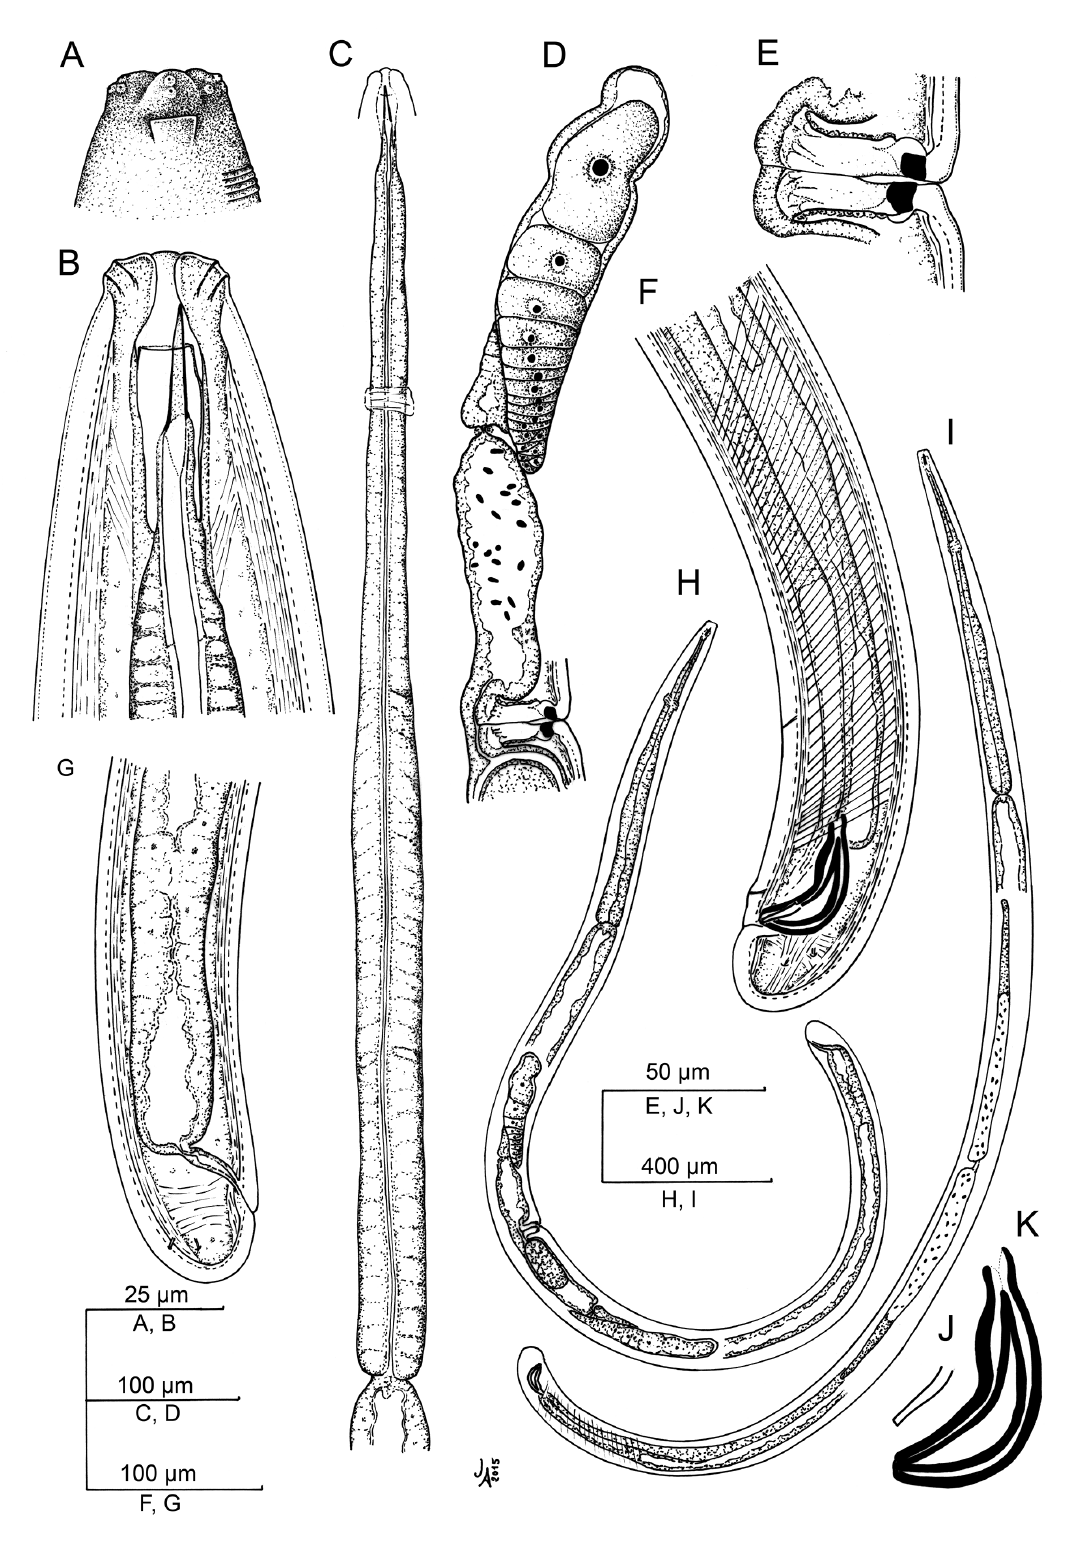
Fig. 1. Sectonema tropicum sp. nov. (Line). A . Lip region in lateral surface view. B . Anterior region in mid-optical level, lateral view. C . Neck region. D . ♀, anterior genital branch. E . Vagina. F . ♂, posterior body region. G . ♀, posterior body region. H . ♀, entire. I . ♂, entire. J . Lateral guiding piece. K .